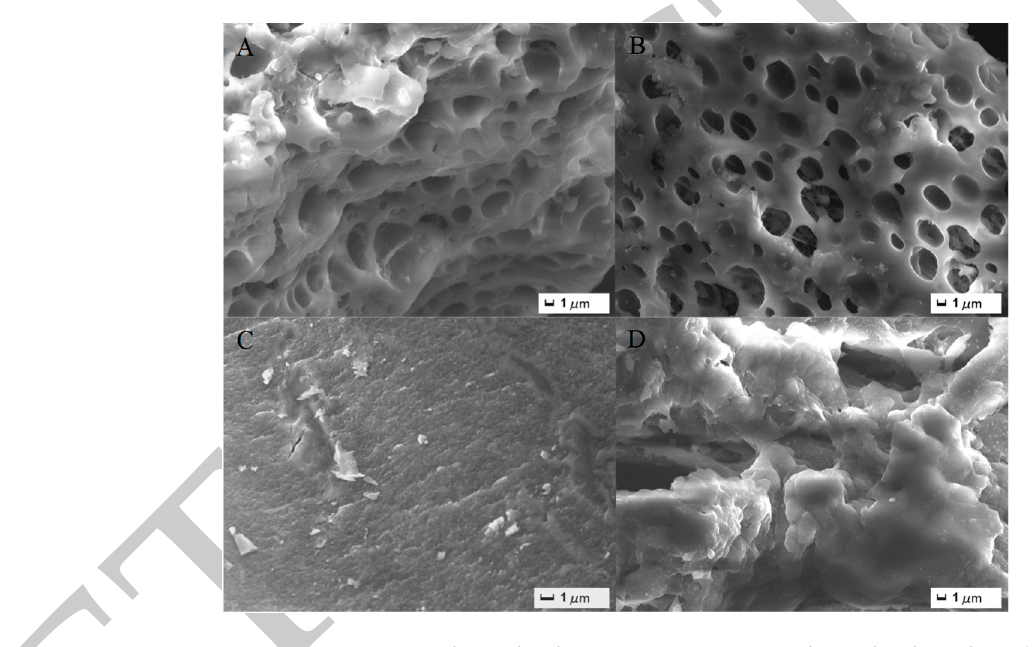
Figure 1. SEM images of PAA/LS/BC ( A,B ), SEM images of PAA/LS/BC after adsorption of Pb 2+ ( C ), and MB ( D ).